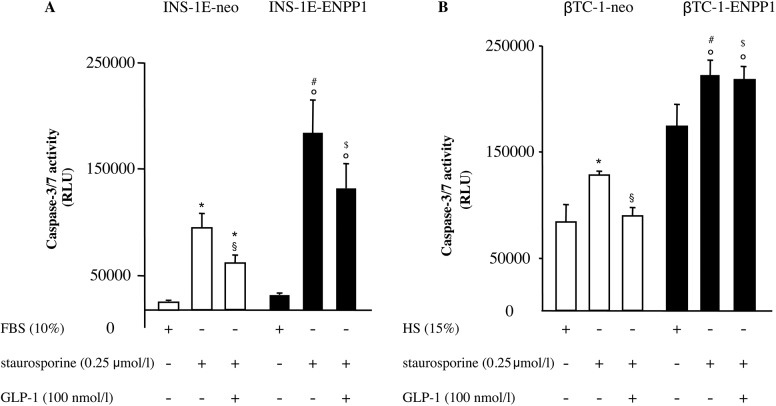
GLP-1 fails to rescue apoptosis in ENPP1 transfected cells.Apoptosis was assessed by caspase 3/7 activity, in INS-1E (panel A) and βTC-1 (panel B) cells, either transfected with neo or ENPP-1 gene variant. Cells were treated with staurosporine (0.25 μmol/l, 2 hours) in the absence or presence of 100 nmol/l GLP-1. Treatment with GLP-1 significantly decreased apoptosis induced by staurosporine in INS-1E-neo and in βTC-1-neo cells but not in INS-1E-ENPP1 and in βTC-1-ENPP1 cells. Values are expressed as means ± SD in INS-1E (n = 7) in βTC-1 (n = 8) independent experiments, each comprising three wells. (* p<0.05 compared with untreated INS-1E-neo or βTC-1-neo cells; § p<0.005 compared with INS-1E-neo or βTC-1-neo cells treated with staurosporine; ° p<0.05 compared with untreated INS-1E-ENPP1 or βTC-1-ENPP1; # p< 0.05 compared with INS-1E-neo or βTC-1-neo cells treated with staurosporine; $ p< 0.05 compared with INS-1E-neo or βTC-1-neo cells exposed to GLP1).